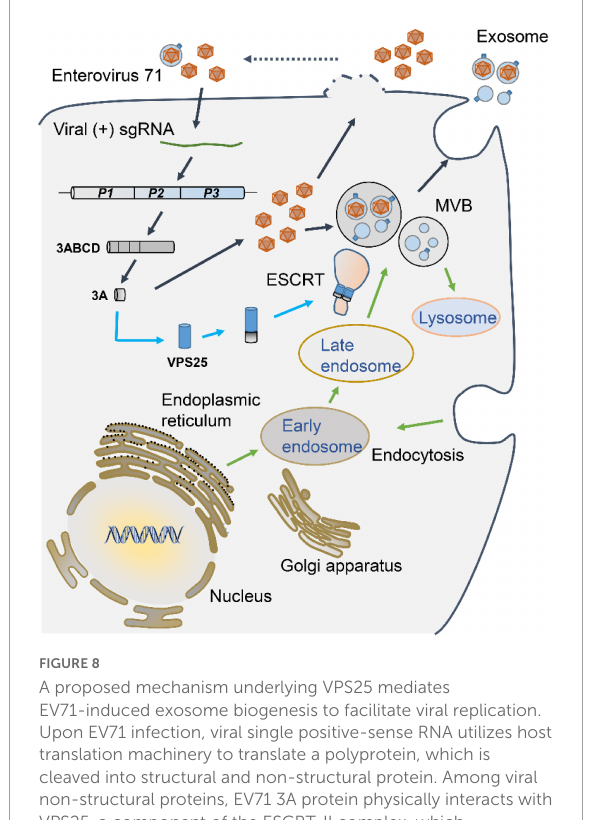
FIGURE8 A proposed mechanism underlying VPS25 mediates EV71-induced exosome biogenesis to facilitate viral replication. Upon EV71 infection, viral single positive-sense RNA utilizes host translation machinery to translate a polyprotein, which is cleaved into structural and non-structural protein. Among viral non-structural proteins, EV71 3A protein physically interacts with VPS25, a component of the ESCRT-II complex, which participates in MVB generation and exosome biogenesis. The release of progeny EV71 could be in the forms of lytical and non-lytical manners. VPS25-mediated exosomes are engaged in the EV71 transmission and infection, thereby facilitating EV71